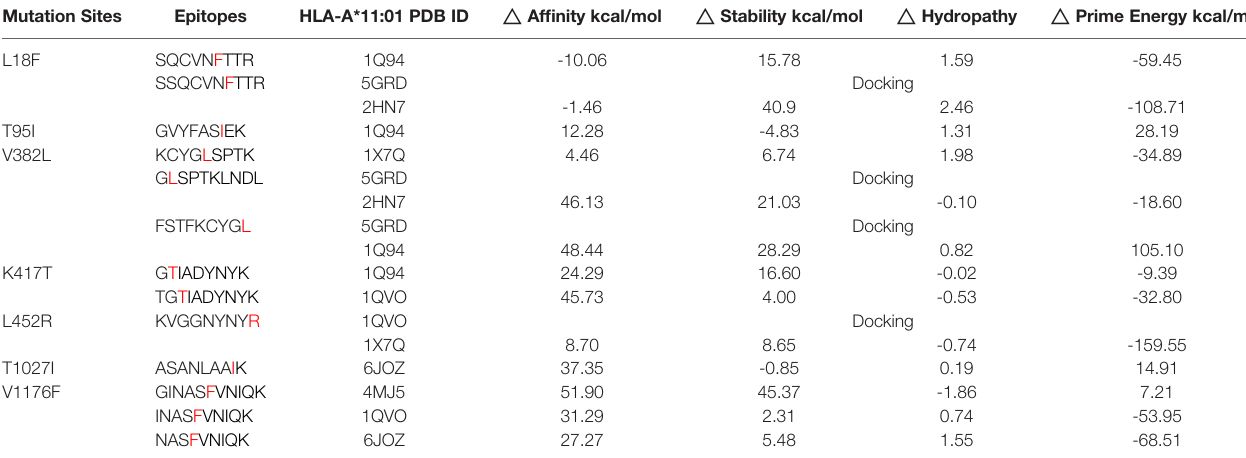
TABLE 2 | The performance of selected epitopes and HLA structures screened according to the minimum △ af fi nity. Mutation